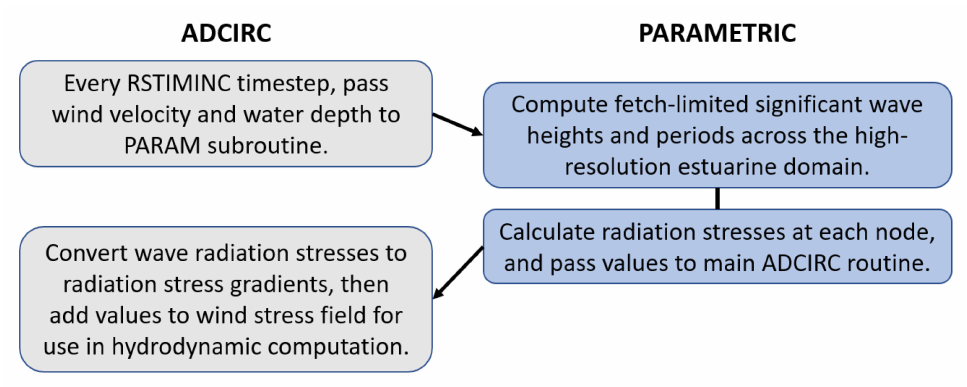
Figure 6. Process Tree Summary of PARAM subroutine integration into ADCIRC. RSTIMINC indi- cates a timestep for wave